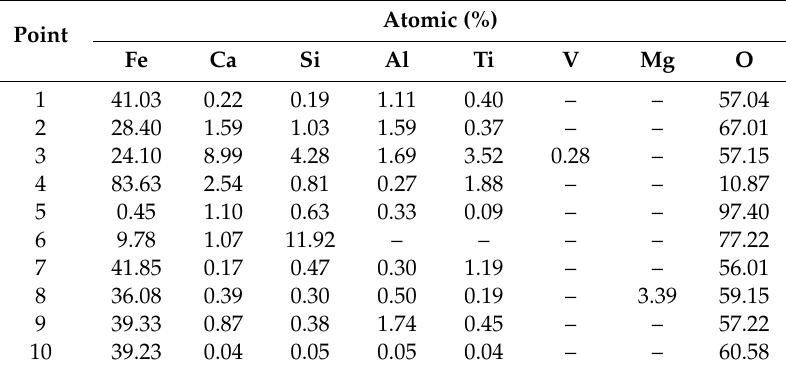
Table 6. EDS analysis for sinter Blend 2 sintered at 1423 K.